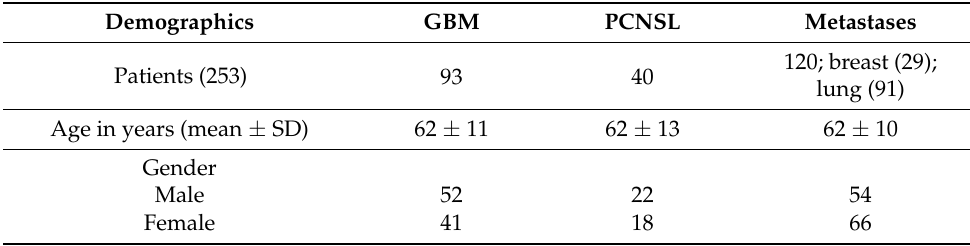
Table 1. Patient demographics and tumor characteristics.